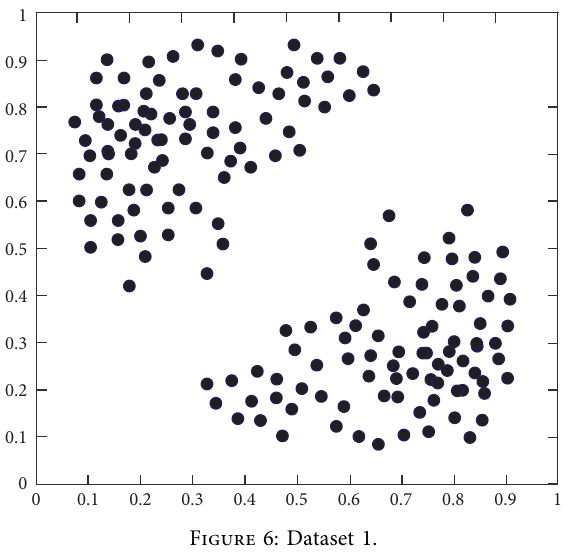
Figure 6: Dataset 1. Figure 7: Dataset